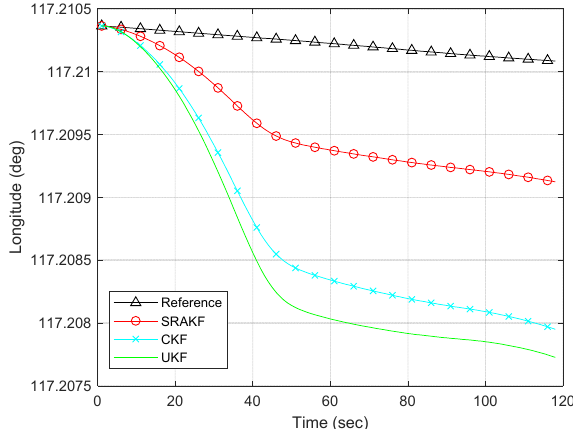
Figure 11. Latitude positions for the underwater lake trial.